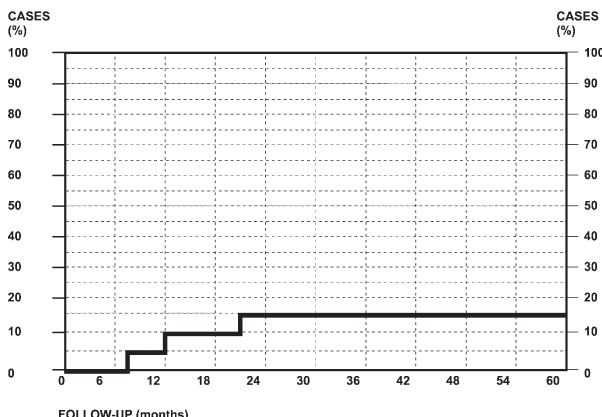
Figure 1 - Kaplan-Meier estimates for local